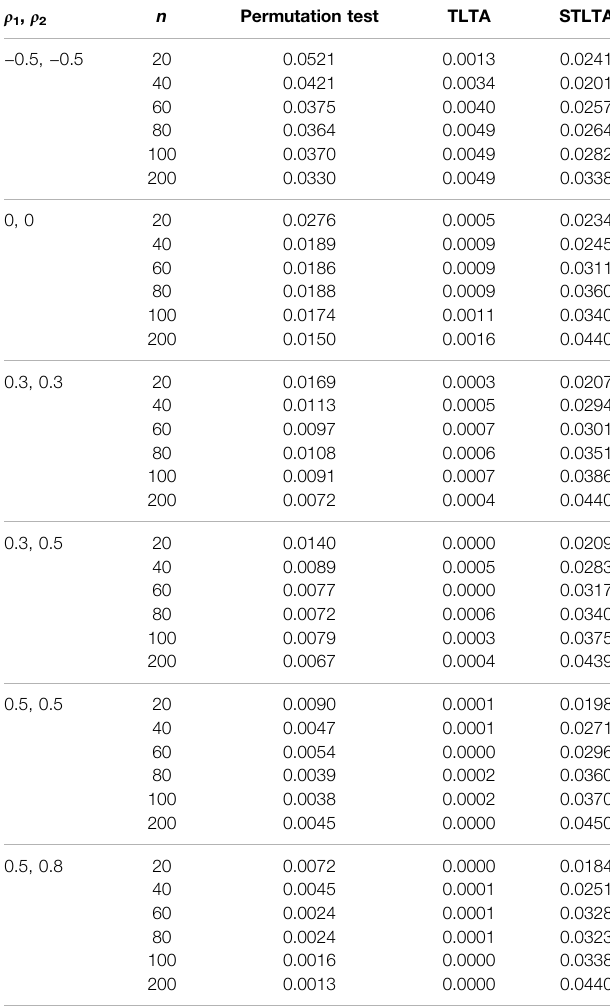
TABLE 5 | Type I error rate for different methods (the third to fi fth columns) in the ARMA(1,1) model when t = 0.5. The fi rst and second columns represent different combinations of autoregressive coef fi cients and sample sizes. The number of permutation tests is 1,000, the number of repeated simulations is 10,000, and the signi fi cance level is α = 0.05.